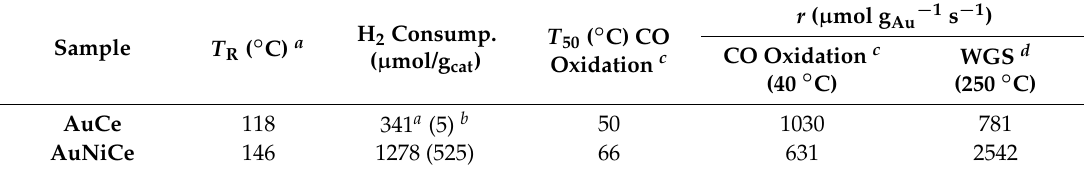
Table 2. H 2 reduction temperatures ( T R ); H 2 theoretical and real consumption values; temperatures of 50% conversion ( T 50 ) and reaction rates ( r ) of CO oxidation and WGS reactions for AuNi/CeO 2 samples.